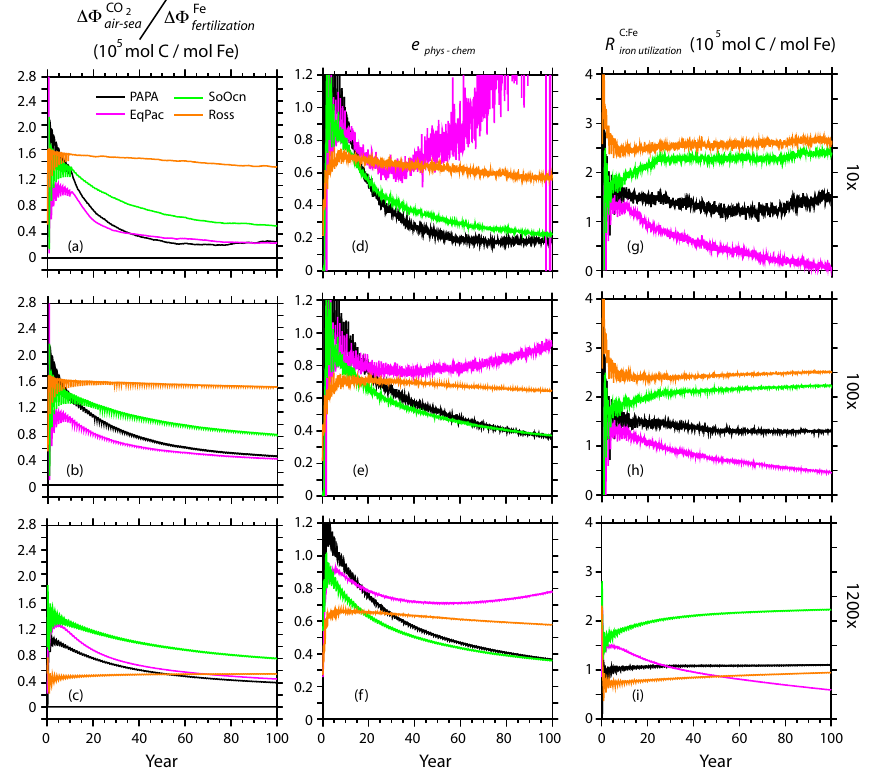
Fig. 9. Results from the iron fertilization scenarios plotted as a function of time from 0 to 100 years of (a–c) , the efficiency of CO 2 uptake CO2 = 18 air − sea with respect to iron addition, R C : Fe , (d–f) the physical-chemical efficiency e phys − chem , and, (g–i) , the biogeochemical overall 18 Fe fertilization response function, R C : Fe . The first row of results is for the 10x scenarios, the second for the 100x scenarios, and the bottom row is iron utilization for the 1200x scenarios.